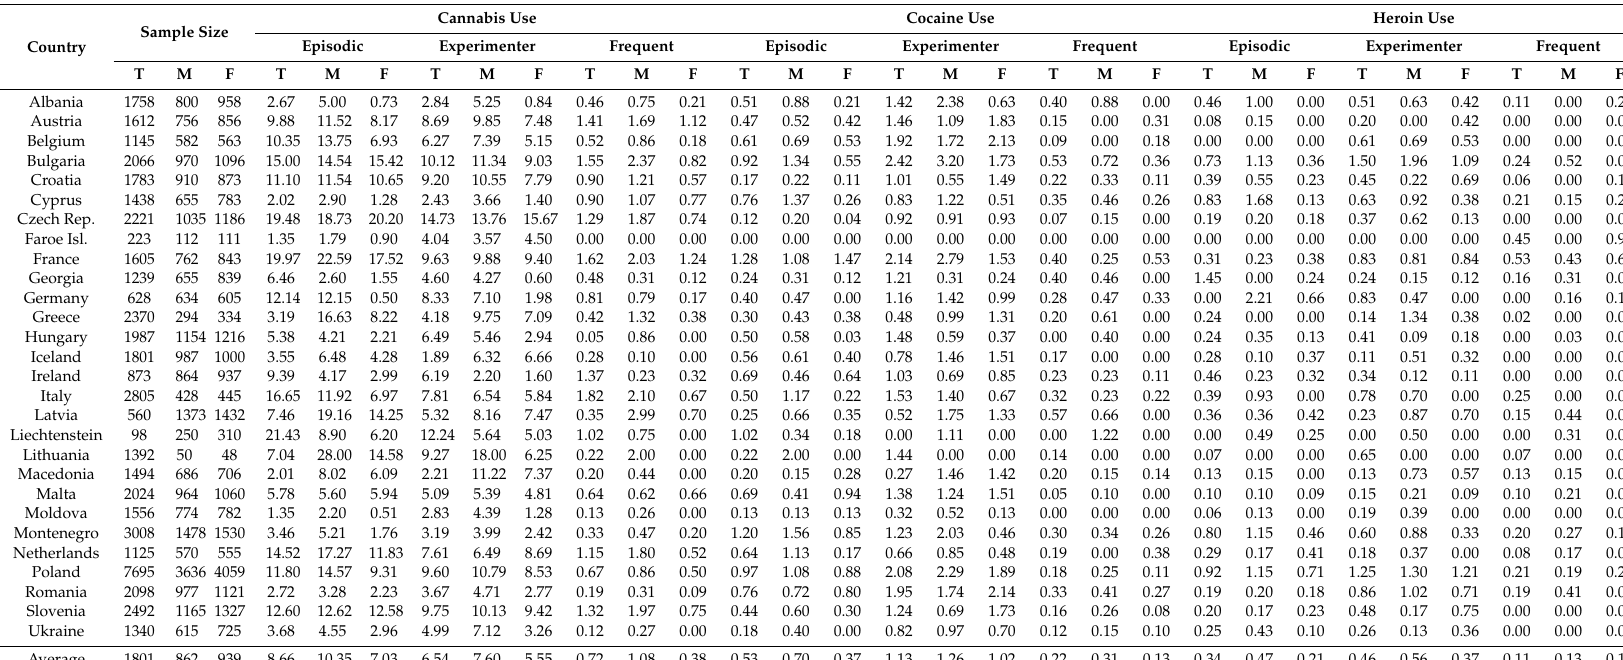
Table 1. Descriptive